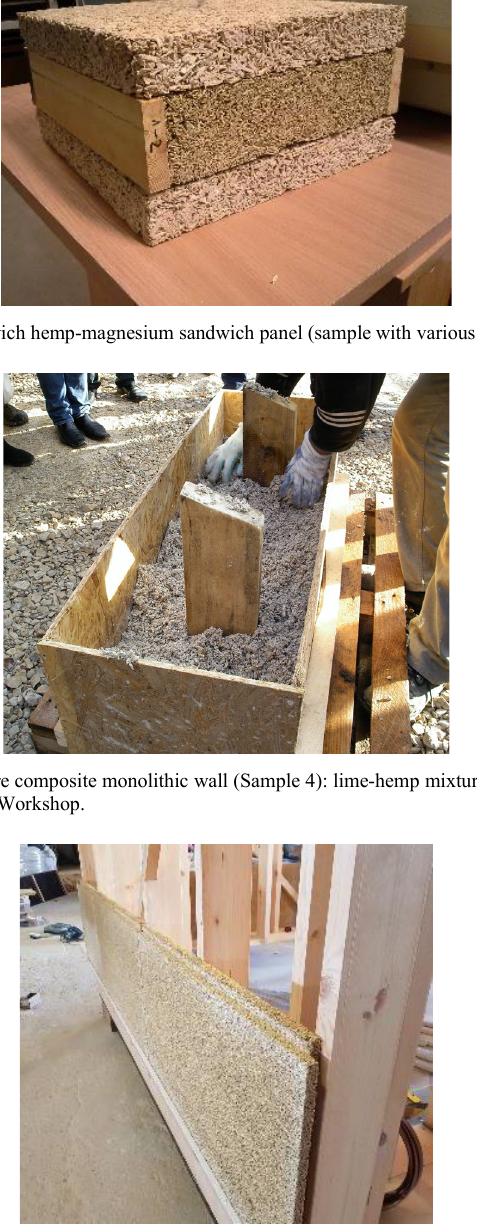
Fig. 7. Sandwich hemp concrete wall full-sized panel: dense MOC-hemp composite slabs on the outer sides; light-weight lime-hemp composite to be filled in internal